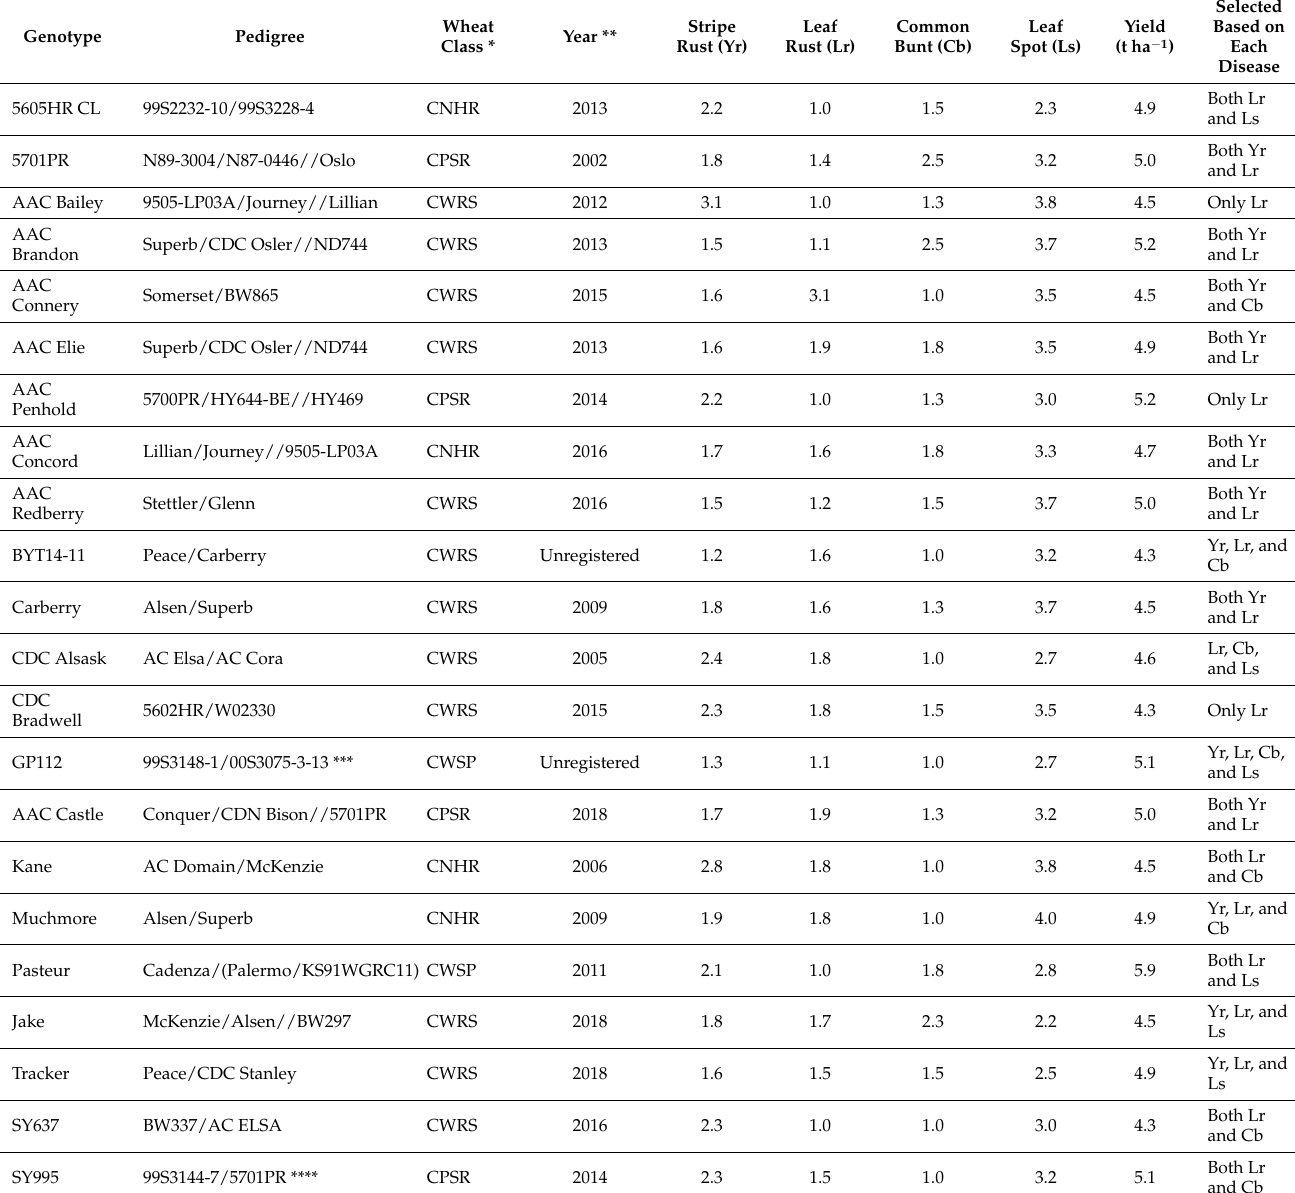
Table 1. Summary of the pedigree and phenotype data of 20 cultivars and 2 unregistered lines chosen as potential parents based on a restricted linear phenotypic selection index. The last column provides additional information on whether the 22 genotypes were also chosen based on the mean severity of each disease